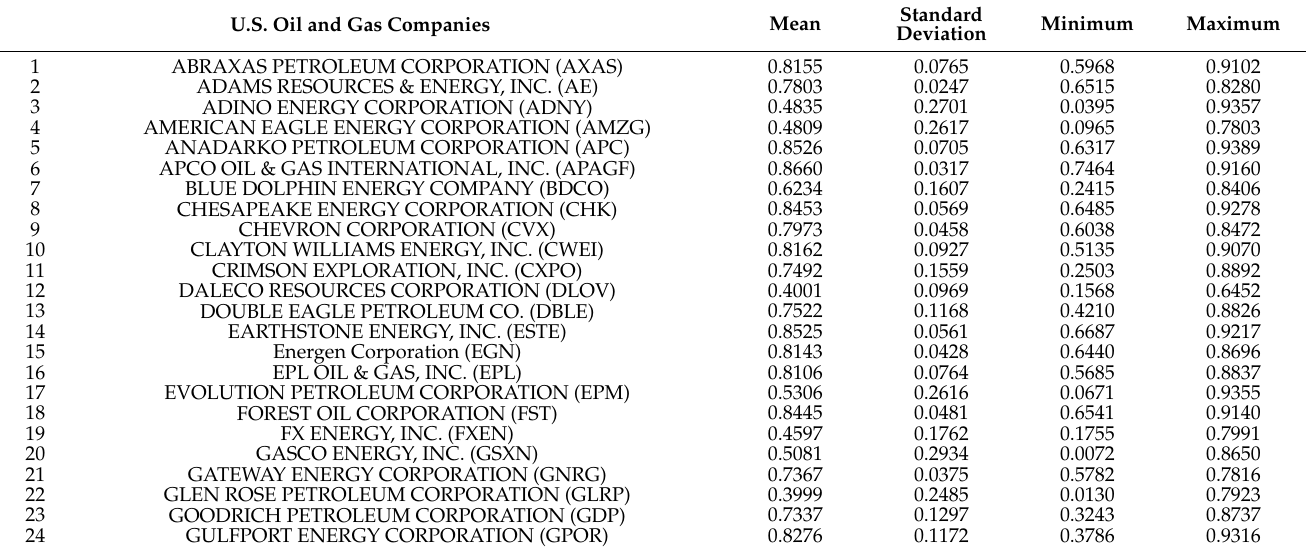
Table A1. Efficiency scores of U.S. oil and gas